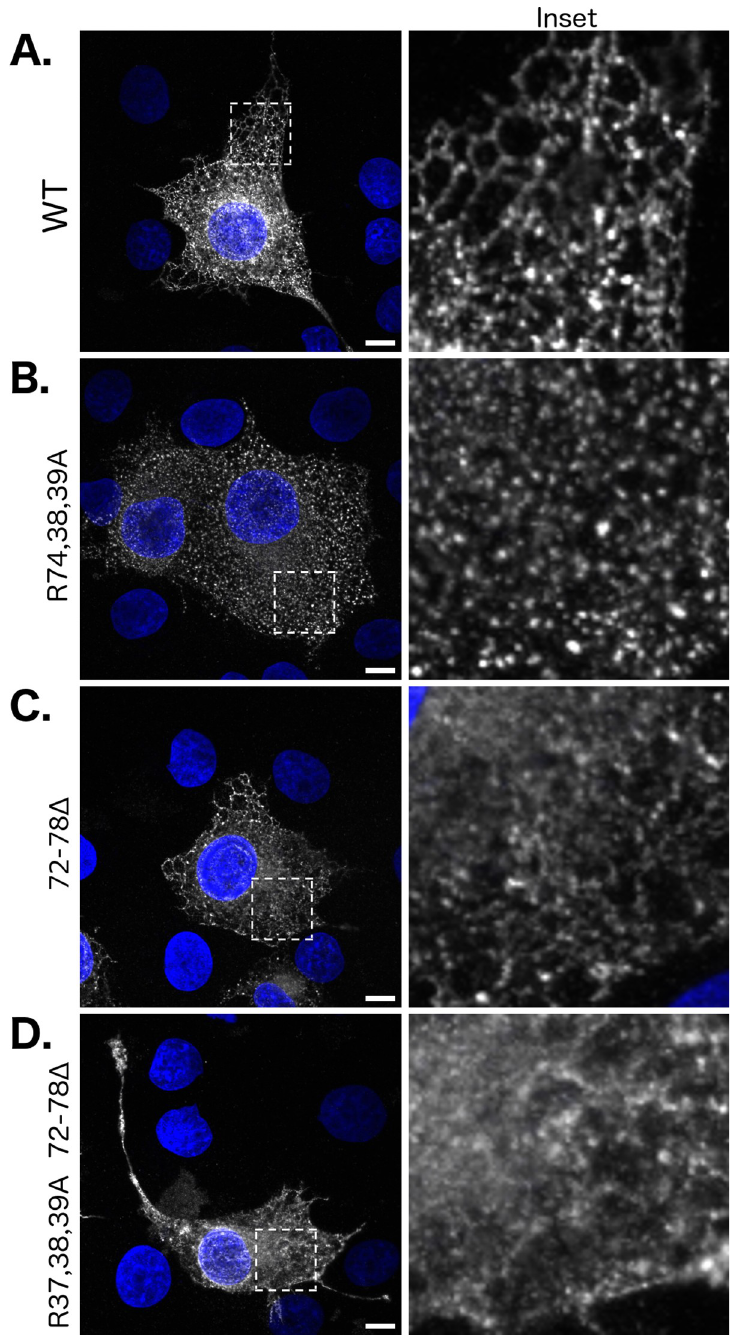
Fig 4. Reticular ER localization falls apart for PRA1 constructs with incomplete Golgi targeting information upon mutation of both di-arginine and FFAT-like motifs. The PRA1 1-131 truncation construct, previously demonstrated to be retained within the ER, was fused to the Snorkel-Tag. The following constructs were expressed in COS-7 cells: (A) WT, (B) R37,38,39A, (C) 72–78 Δ , and (D) R37,38,39A/72-78 Δ . Constructs were immuno-localized using an anti-FLAG antibody. Images are representative of at least three transfections and are compiled from a 6 μ m z- section. Insets are magnifications of an area within the displayed images, highlighted with a dashed-line. Scale bar: 10 μ m. White: PRA1, Blue: Nuclear labeling via